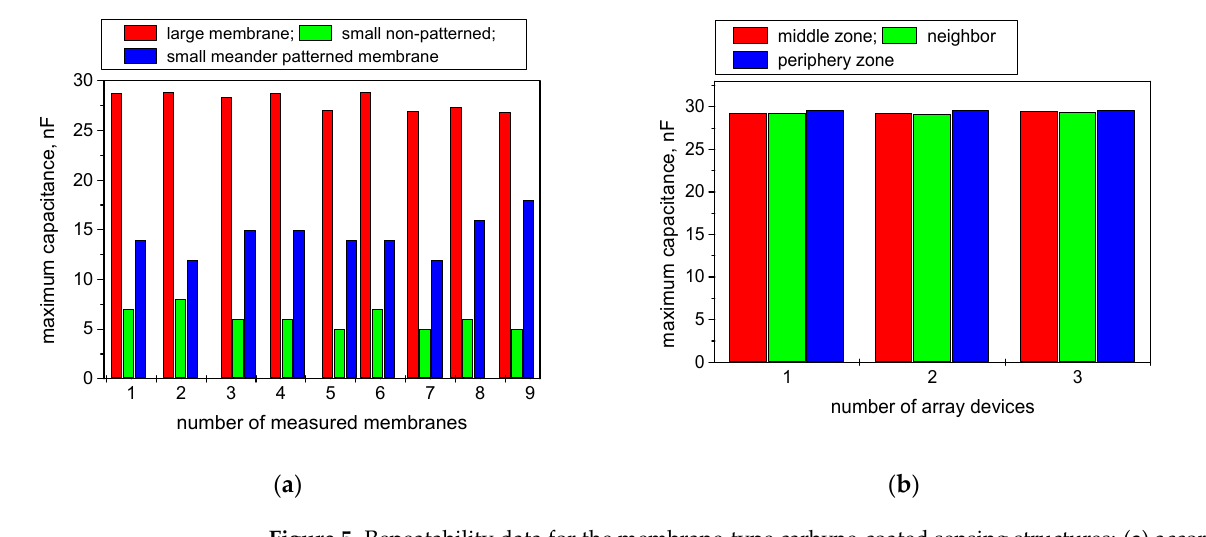
Figure 5. Repeatability data for the membrane-type carbyne-coated sensing structures: ( a ) according to the membrane shape and size; ( b ) according to the sensing element location across the substrate.